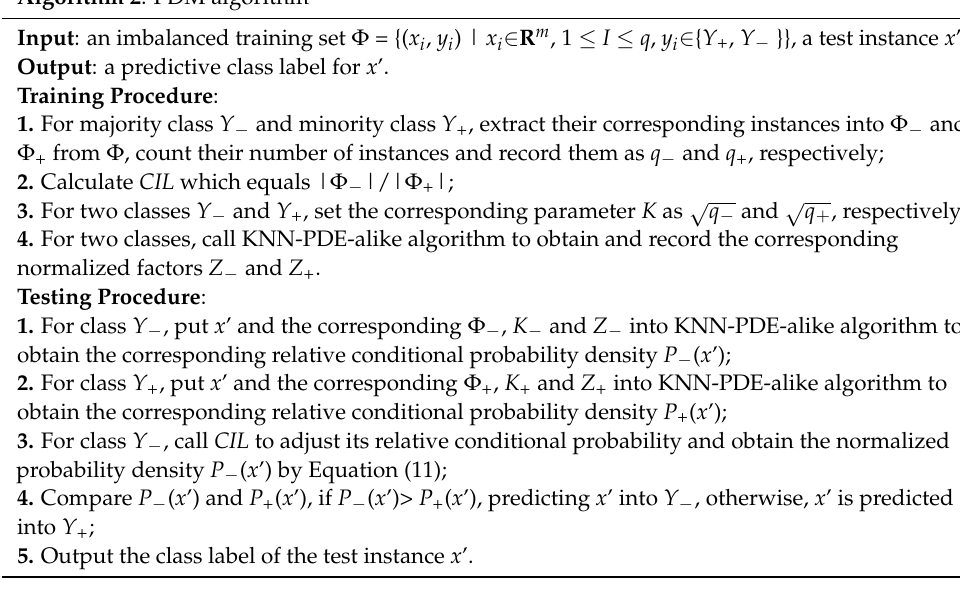
Algorithm 2 . PDM